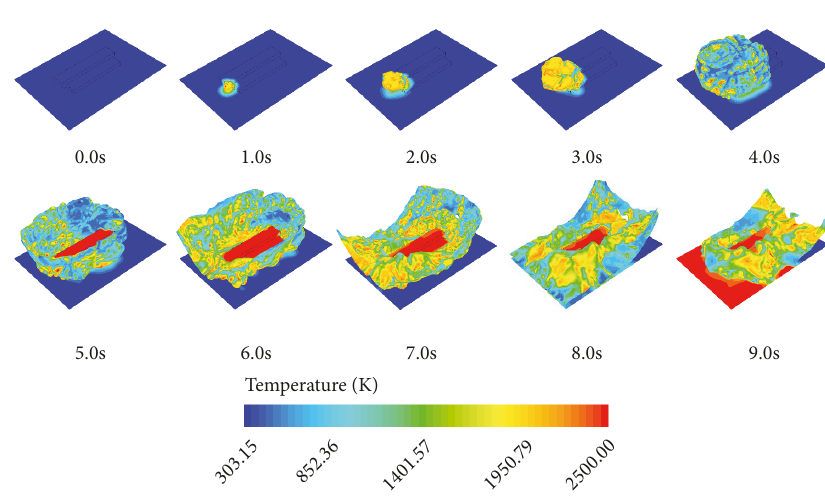
Figure 10: Natural gas deflagration at fuel volume fraction 15.0% (equivalence ratio 𝜑 = 1.7 ).